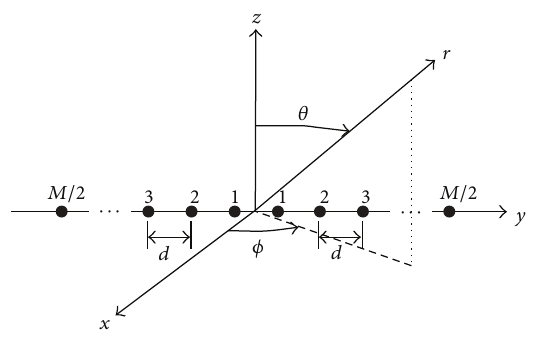
Figure 1: Linear array with elements along the 𝑦